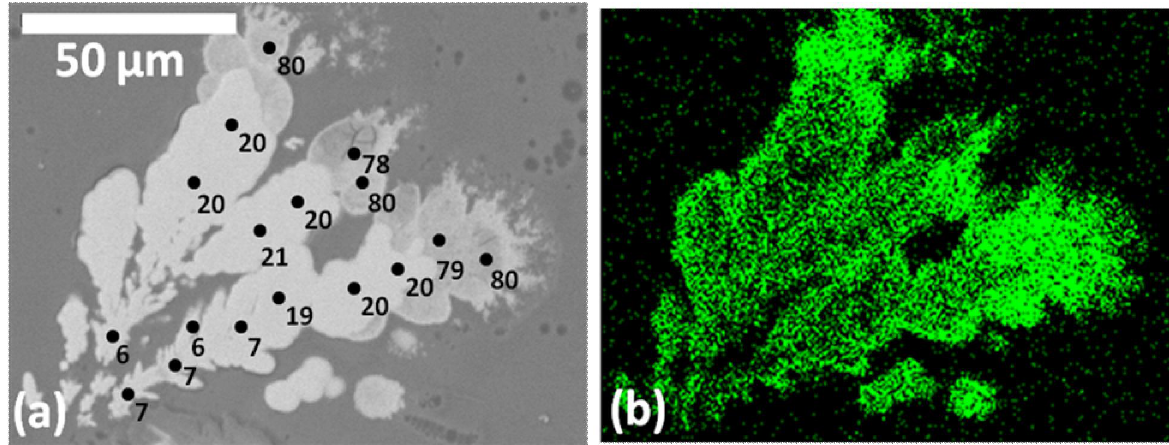
Figure 2. ( a ) Back scattered electron image showing composition along dendrite (at.% Mg); ( b ) Mg composition map of the